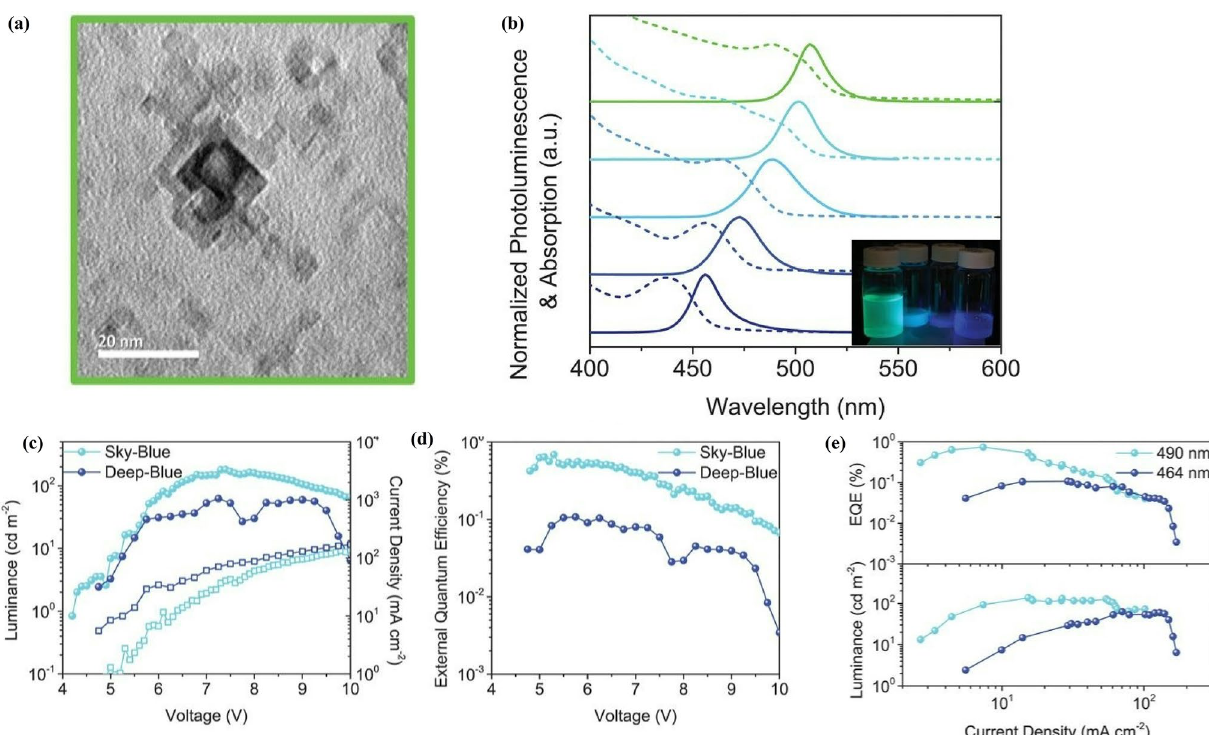
luminance (L) displayed by circles. d External quantum efficiency as PbBr nanocubes b 1–x 3 a function of applied bias. e Devices that exhibited the largest lumi- nance at their peak EQEs. Adapted with permission from ref. [84], copyright 2019, WILEY ‐